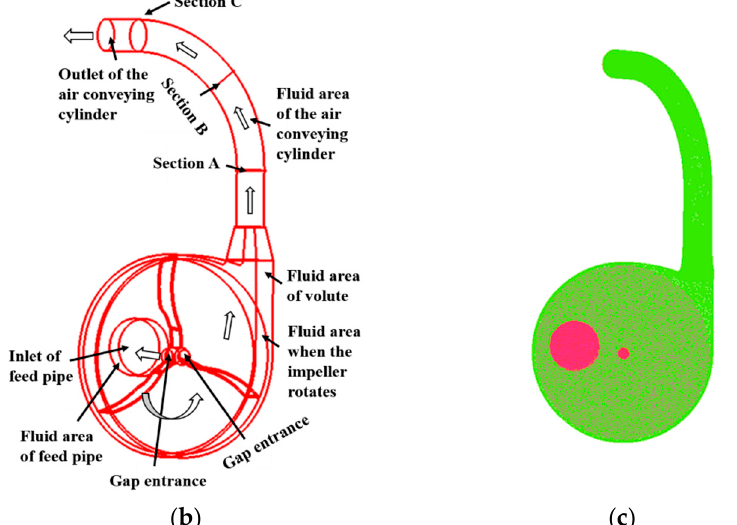
Figure 4. Process of establishing flow channel model of the integrated device. ( a ) Three-dimensional model of integrated device. ( b ) Flow channel model of integrated device. ( c ) Grid map of the flow channel of the integrated device.